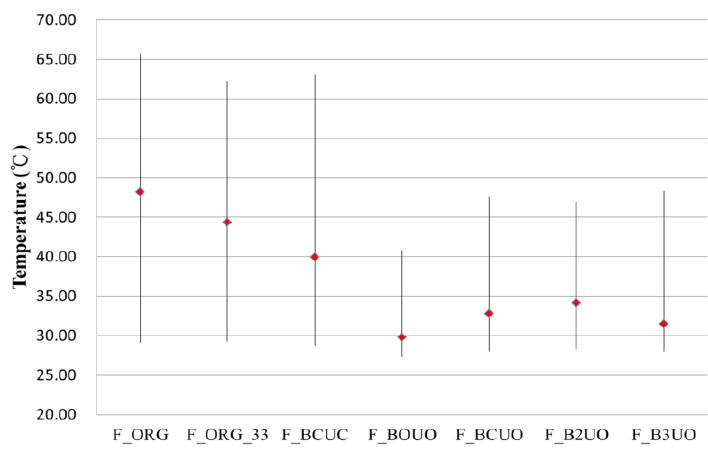
Figure 13. Temperature variations from 60 s to 240 s at Point R (at a height of 1.8 m).